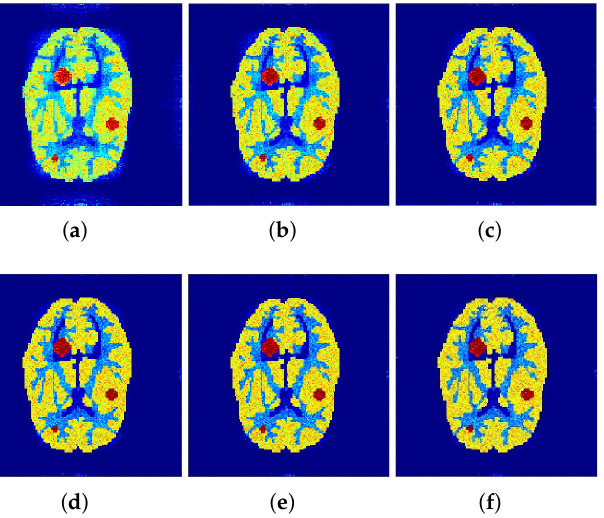
Figure 2. Conventional MLEM reconstructions. ( a – c ) row: iterations 20, 40, and 60. ( d – f ) row: iterations 80, 100, and 120.